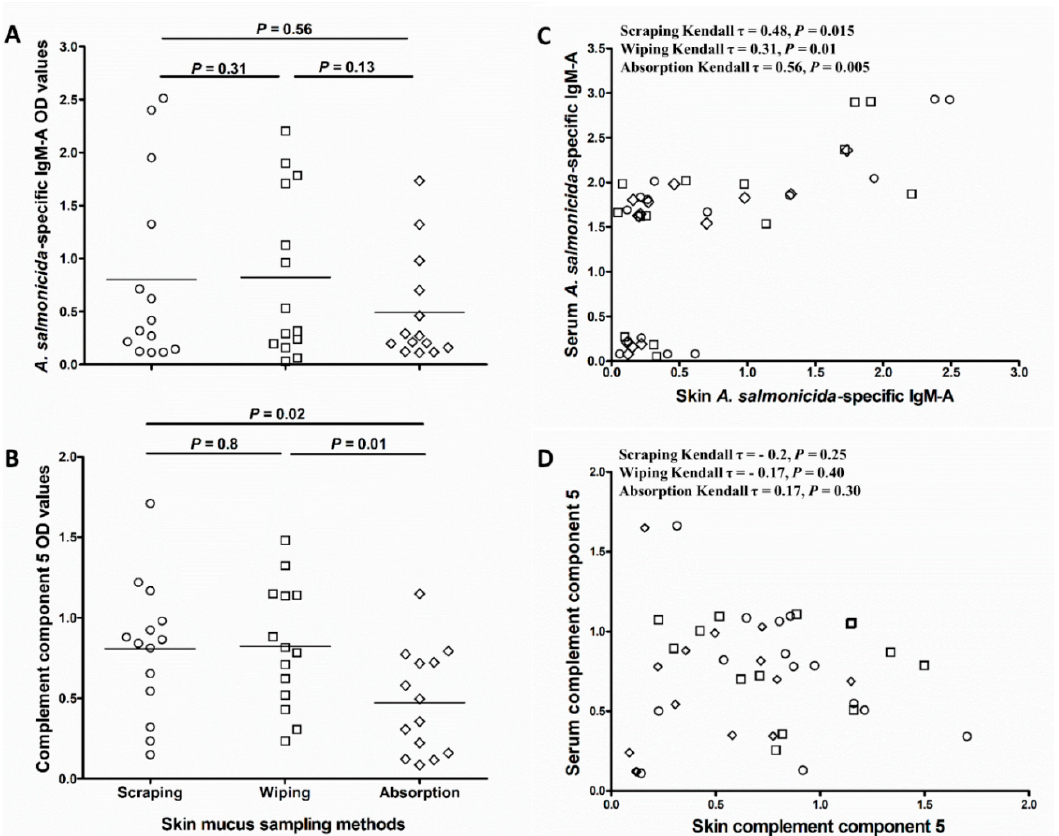
Figure 4. Influence of skin mucus sampling method on the downstream analysis of specific IgM-A and complement component 5 in skin mucus. Scatter dot plots comparing ( A ) A. salmonicida -specific IgM-A OD values (obtained using ECAS-CIA) and ( B ) complement component 5 OD values (obtained using ELISA) of mucus samples collected by the three different methods (D2; n = 14). The nonparametric multiple comparisons test (Wilcoxon each pair) was performed to calculate the significance of the OD value differences between the three methods. Horizontal lines in “A” and “B” represent the median OD values in different groups. Kendall’s rank test of correlation ( τ ) between ( C ) A. salmonicida -specific IgM-A or ( D ) complement component 5 OD values in skin mucus (collected by the three different methods) and the corresponding values in serum samples.